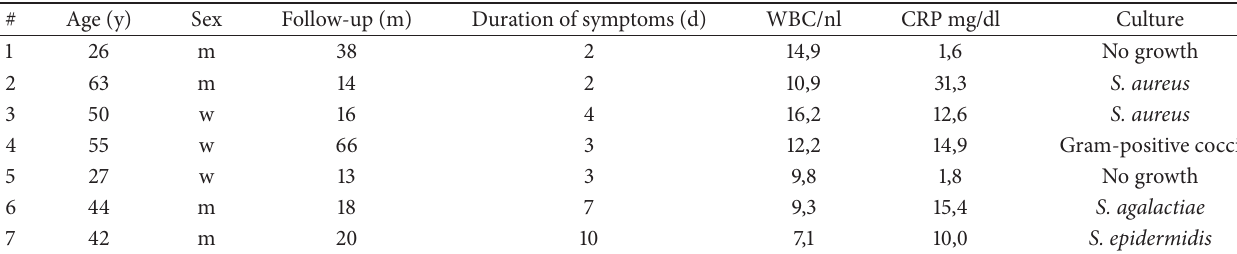
Table 1: Patients’